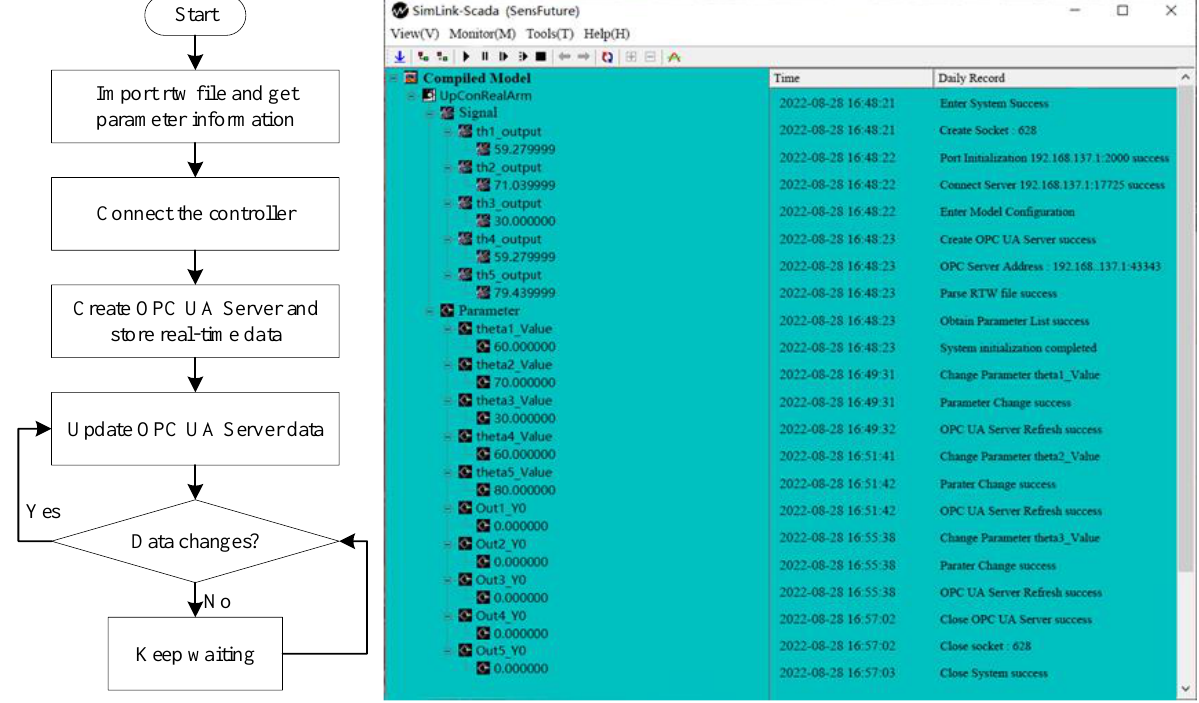
Figure 8. Data flow of OPC UA server and software interface.